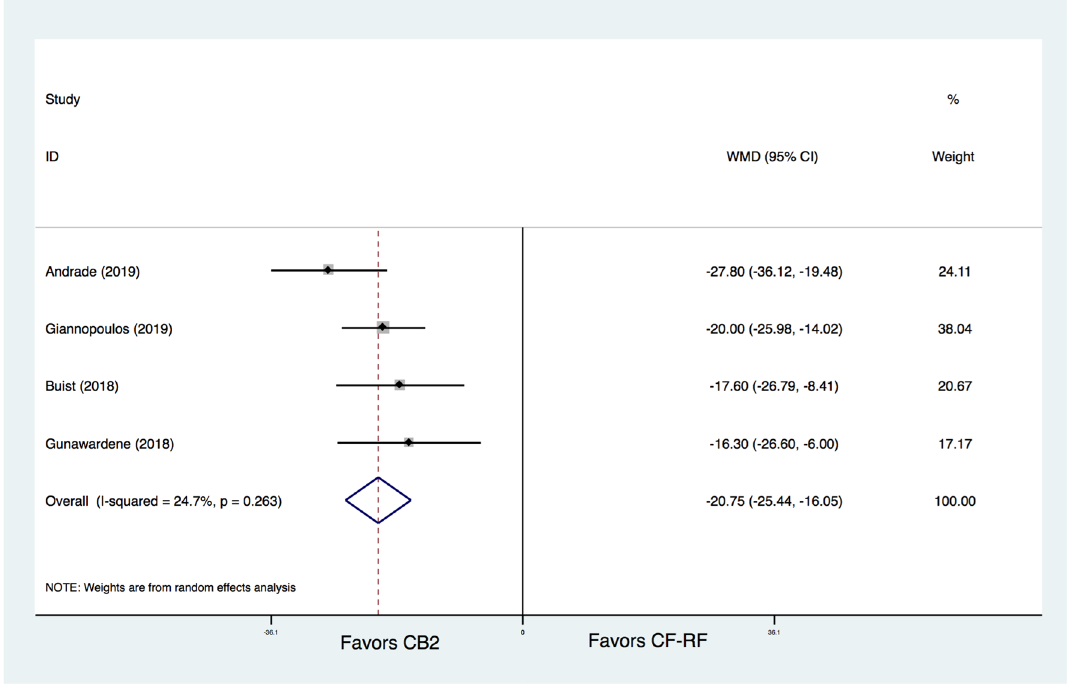
Figure 6. Meta-analysis for the outcome of procedure time. CF-RF = contact force radiofrequency ablation; CB2 = cryoballoon ablation (CBA) with a second-generation cryoballoon; WMD = weighted mean difference.